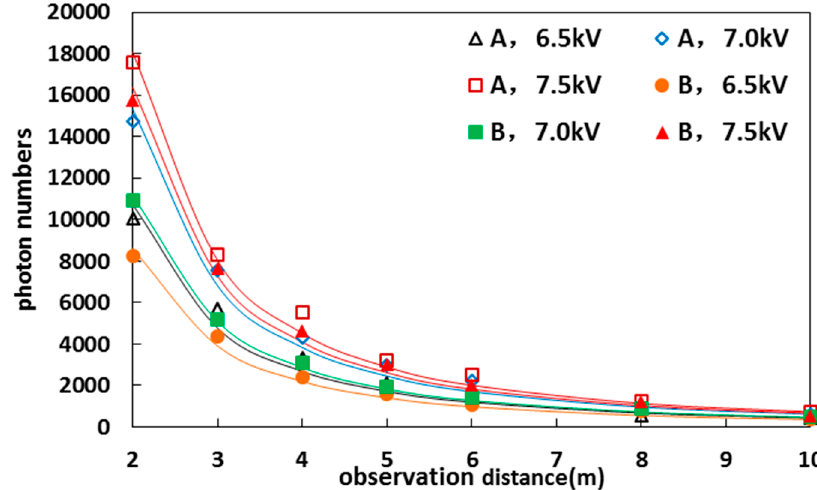
Figure 12 . Influence of observation distance on photon numbers for sample III ( p = 98.02 kPa; T = 22.3 °C; RH = 70.4%).